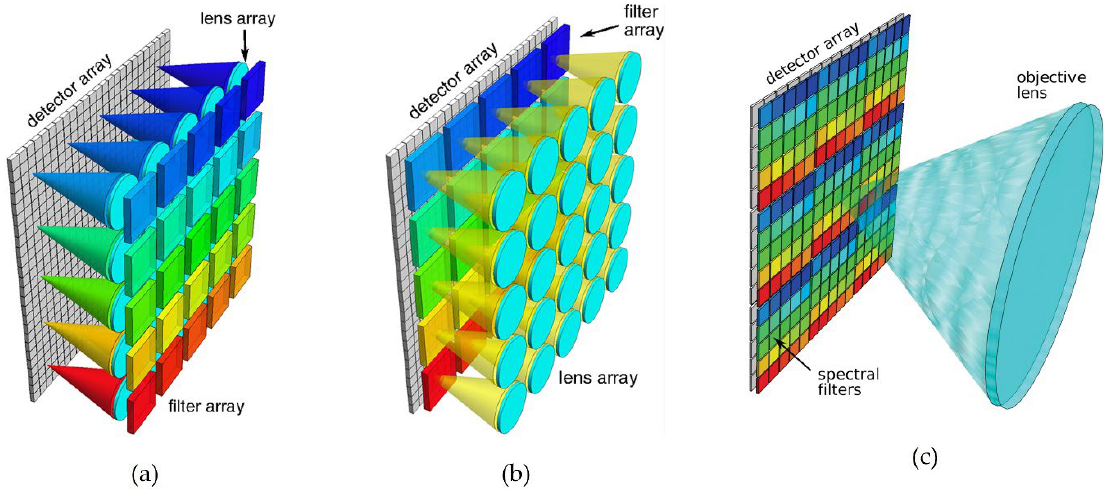
Figure 8. Example of layouts for a multi-aperture-filtered camera system, using ( a ) the Shogenji design and ( b ) IMEC design. ( c ) The system layout for a pixel-level color filter array camera. Reproduced from [43] under license CC BY 3.0.